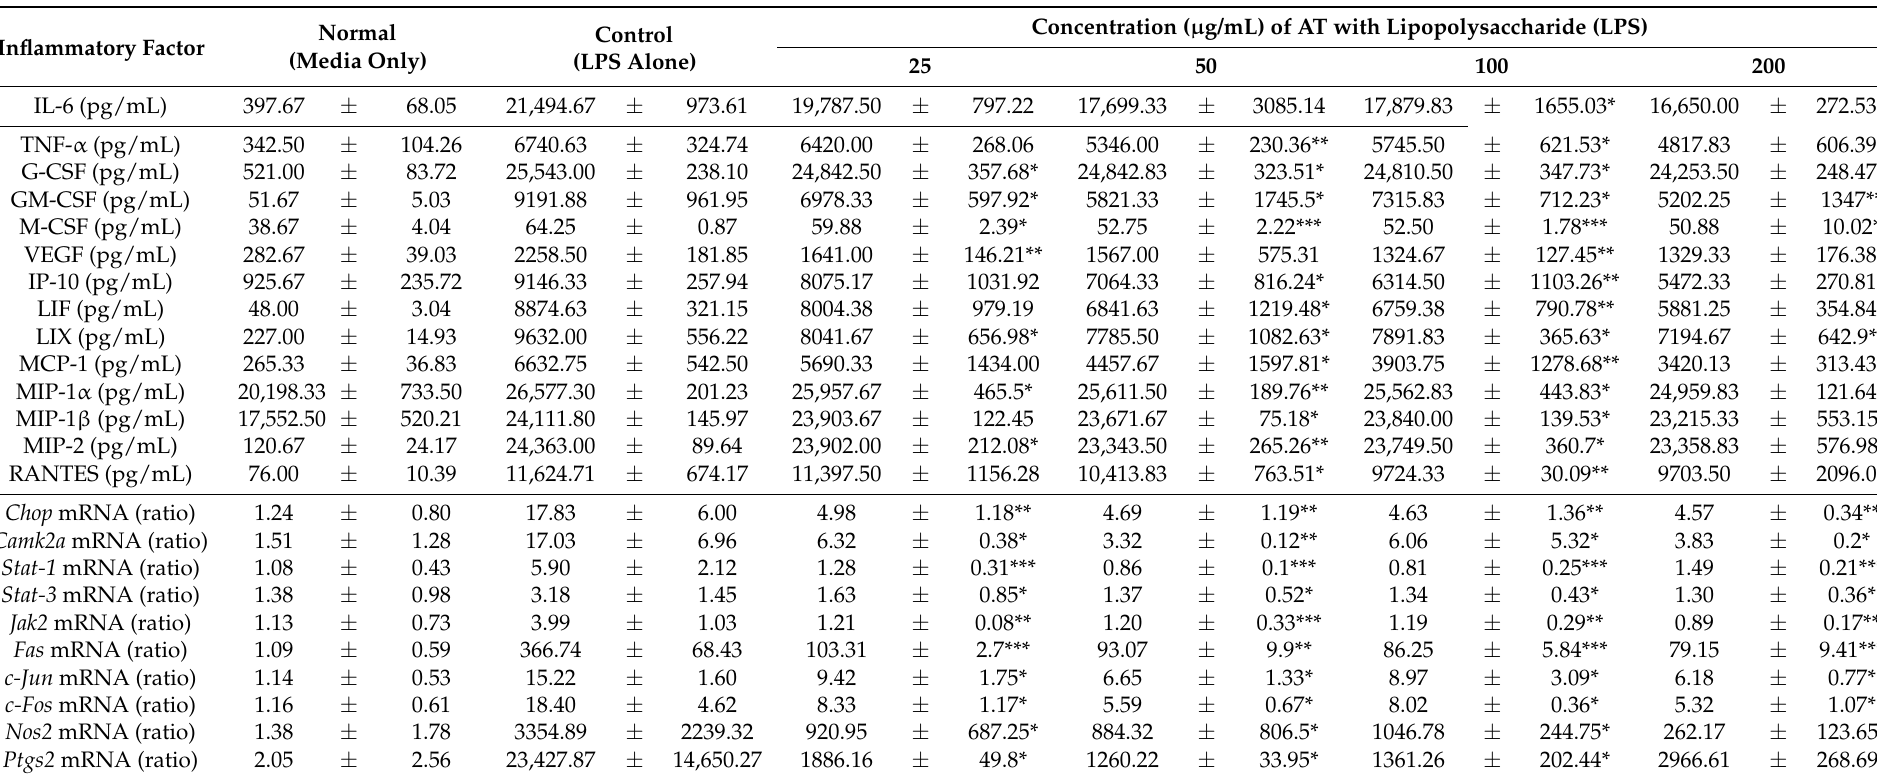
Table 2. Effects of Angelica tenuissima root extract (AT) on hyper-inflammatory responses in RAW 264.7 activated by endotoxin (1 µ g/mL of